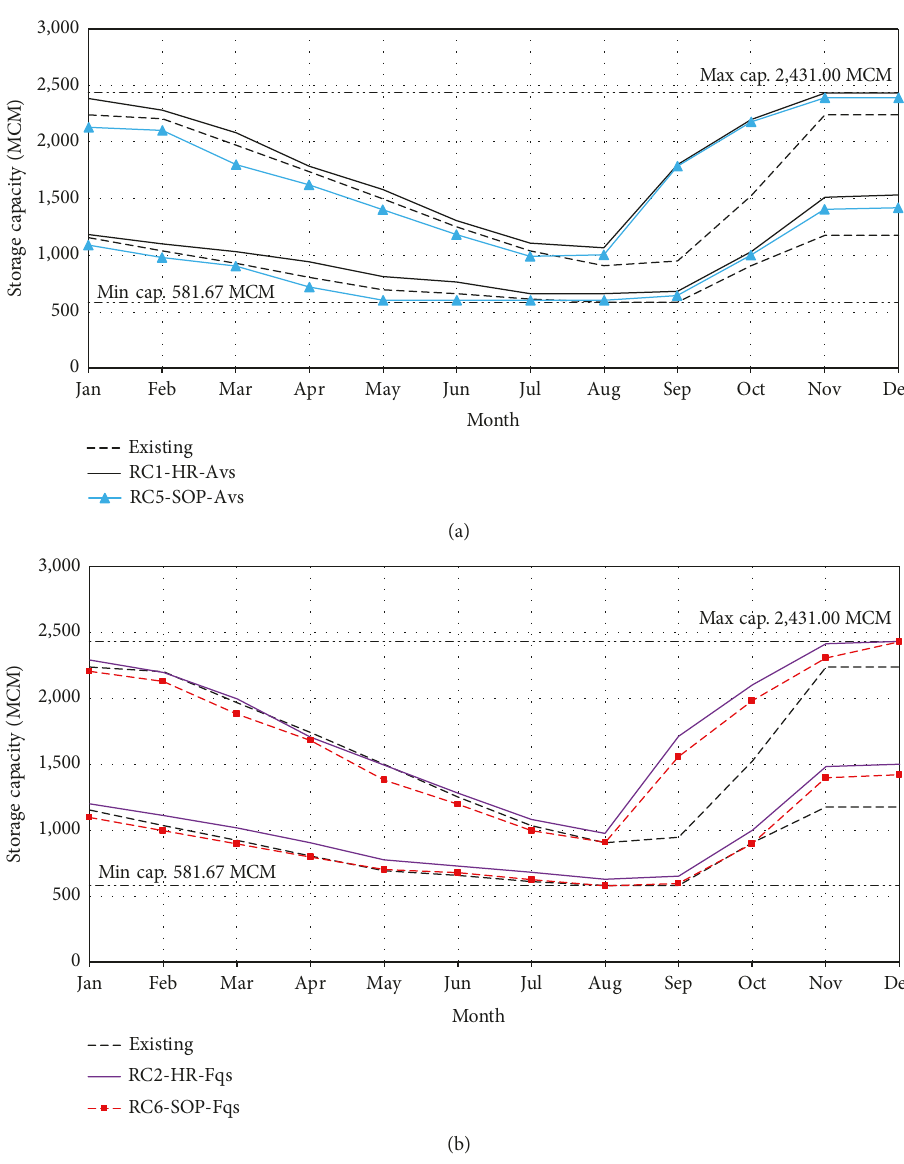
Figure 7: Optimal rule curves of the Ubolratana reservoir considering HR and SOP with objective functions of (a) the minimal average water shortage per year and (b) the minimal frequency of water